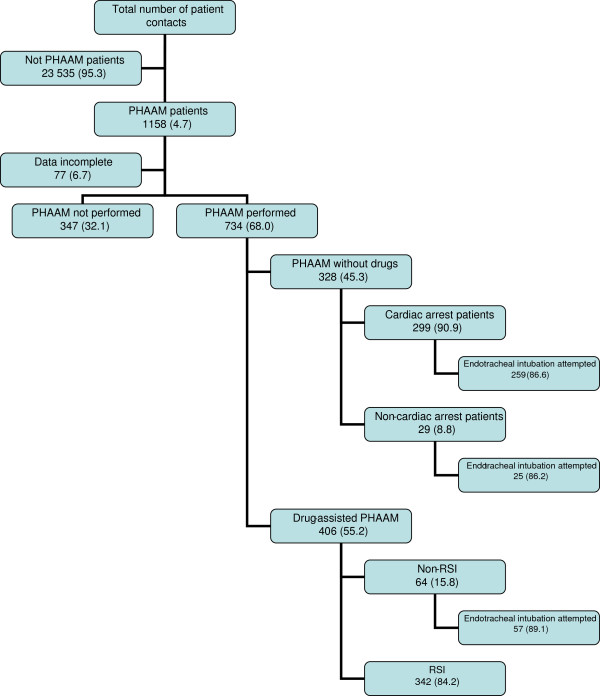
Patient flow. Numbers (%). PHAAM: Pre-hospital Advanced Airway Management. RSI: Rapid Sequence Intubation.